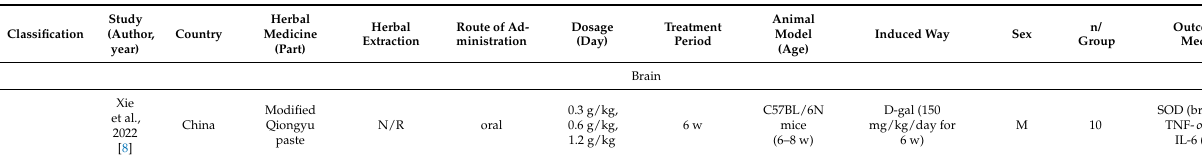
Table 1. In vivo studies of herbal medicines for